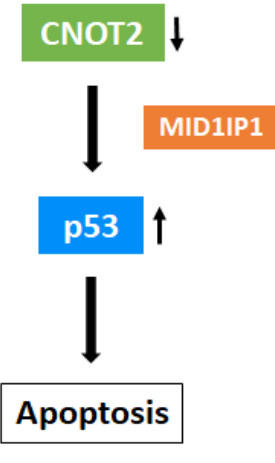
Figure 6. The role of CNOT2 in cancer cells. A mechanistic scheme showing how the inhibition of CNOT2 induces p53 expression and apoptosis. Inhibition of CNOT2 expression induces apoptosis by p53 activation via MID1IP1.